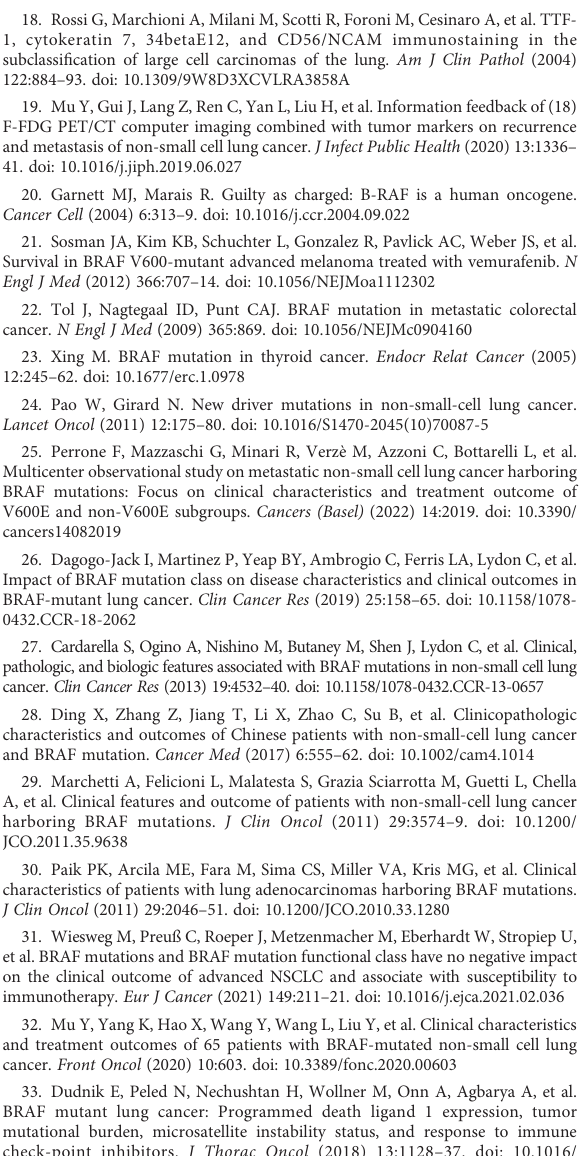
Laboratory results in the period between diagnosis and metastasis. (A) Graph showing the dynamics of CEA tumor marker response during treatment. (B) Graph showing the dynamics of CA125 tumor marker response during treatment. (C) Graph showing the dynamics of CA153 tumor marker response during